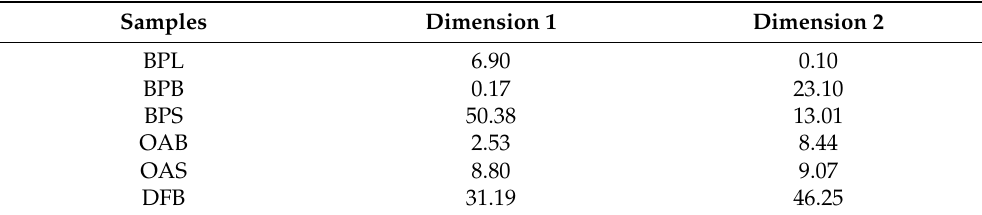
Table 3. Percentage of contribution of each of the samples in the principal component analysis